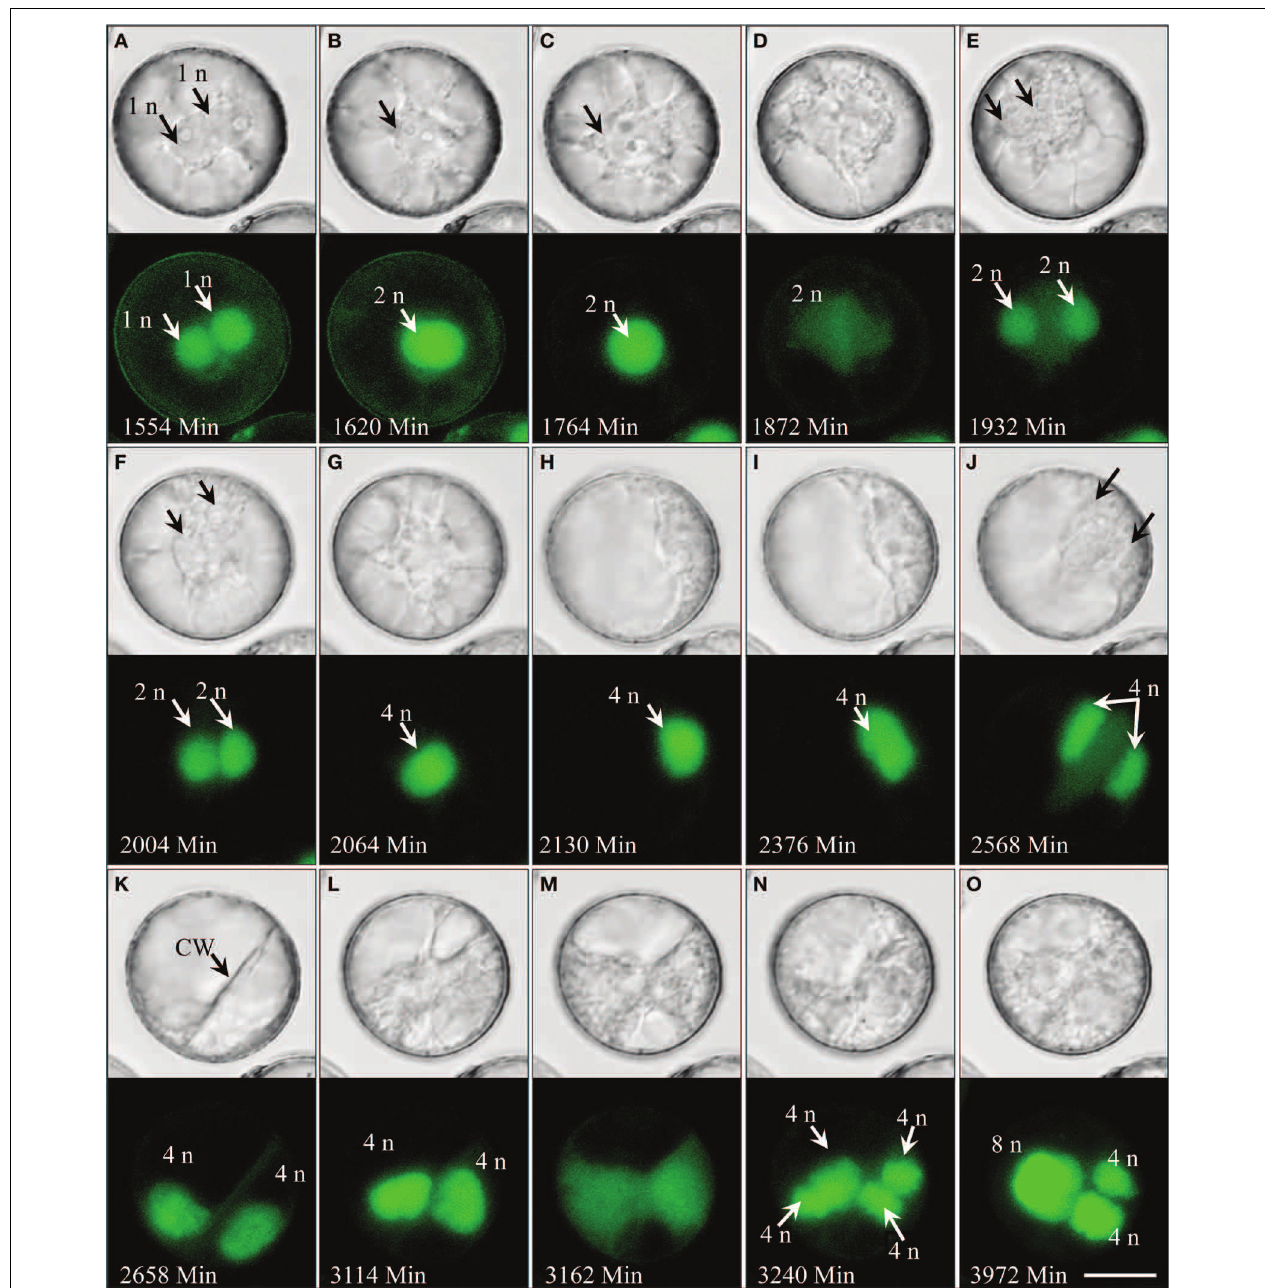
FIGURE 6 | Spontaneous genome doubling during pollen embryogenesis shown by synchronously acquired DIC and fluorescence images of GFP. (A) Two haploid nuclei after the first pollen mitosis. (B,C) Nuclei adhere to one another and eventually fuse to form a diploid nucleus. (D–F) Second mitosis producing a pair of diploid sister